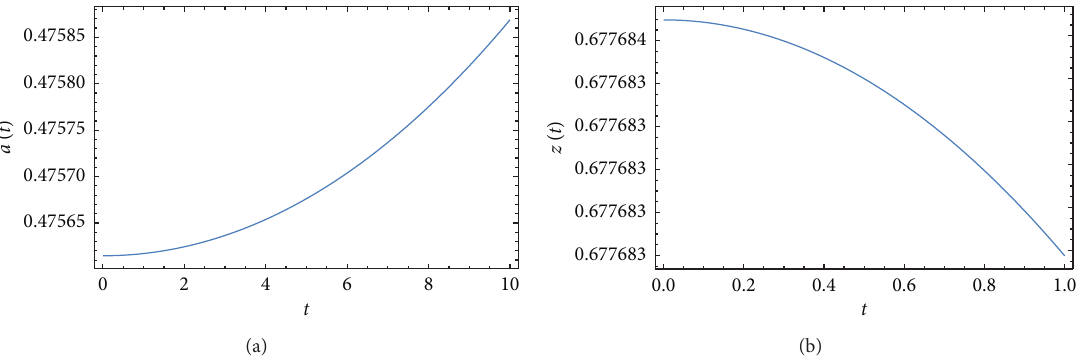
( t ) � − ( k Log ( t + ε ) / t ) − 1 with α � 0 . 001; κ � 0 . 5; ε � 0 . 001; 1